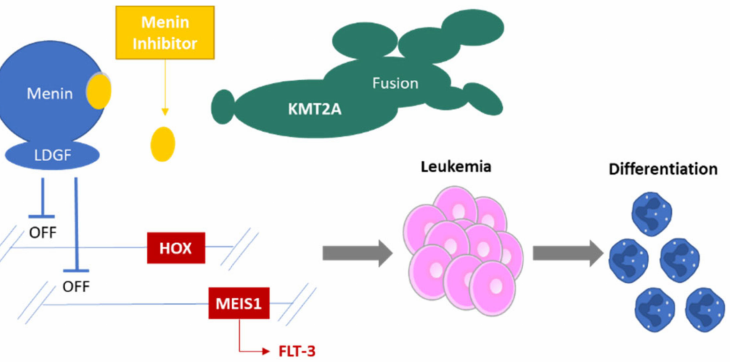
Figure 1. Proposed Mechanisms of Inhibiting Menin. KMT2A r fusion proteins bind menin and lead to a stereotyped gene profile expression which includes HOX family genes and MEIS1 leading to a leukemia stem cell like state. The menin inhibitors disrupt binding to menin reducing this gene expression and leading to cell differentiation. FLT3 expression is regulated by upstream factors including MEIS1. Mutated NPM1 also up-regulates the expression of HOXA9 and MEIS1 possibly by cytoplasmic sequestration of transcriptional regulators (such as HEXIM1) which normally inhibit components of KMT2A r fusion protein complexes. Table 1. Menin Inhibitors in Clinical Trials. Note: Aza, azacitidine; KMT2Ar histone-lysine-N- bicin and dexamethasone; R/R, relapsed or refractory; ven,